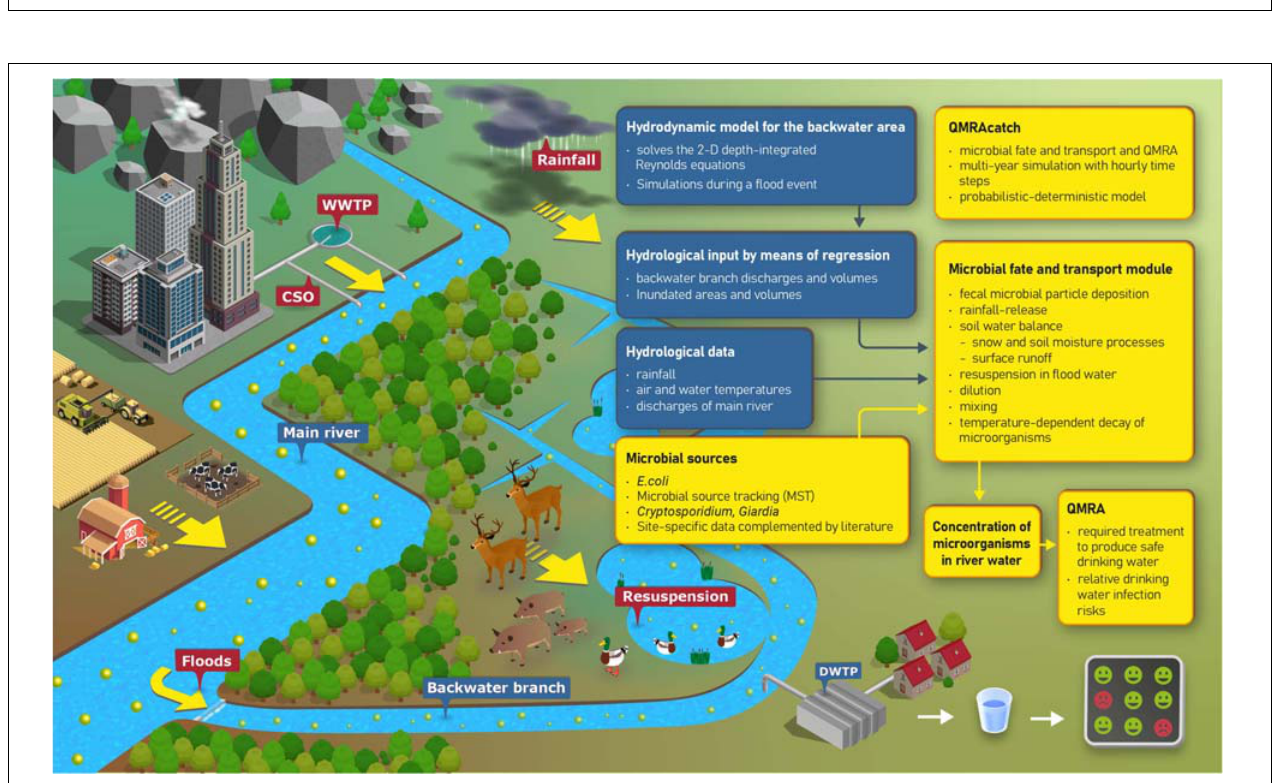
FIGURE 2 | Microbial sources and transport processes in the alluvial backwater area (graphics). Components and data flows of the integrative modeling approach (flow chart).